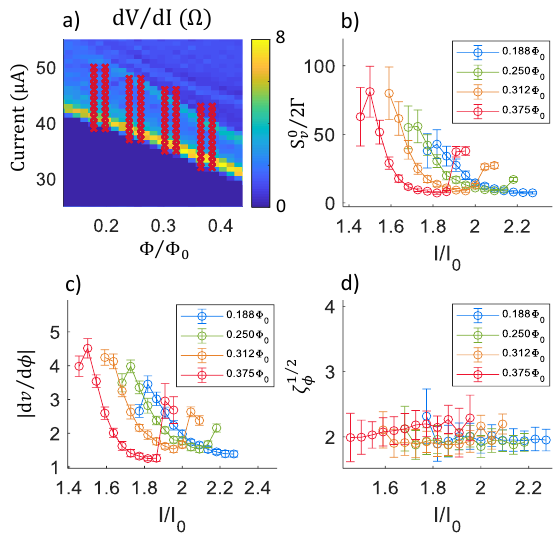
Figure 7. Noise calculations for a damped SQUID along the critical curve: ( a ) Plot of dV / dI vs. current ( I ) and flux ( Φ ). The crosses correspond to the values of I and Φ for which noise was calculated. ( b ) Plots of the dimensionless low-frequency voltage noise power S 0 v /2 Γ vs. current I for four different flux values. ( c ) Plots of the dimensionless transfer junction | d ν / d φ | . ( d ) Plots of the dimensionless flux noise ζ 1/2 . The schematic used for these calculations was that of Figure 3d, with I 0 = 22 µ A, φ